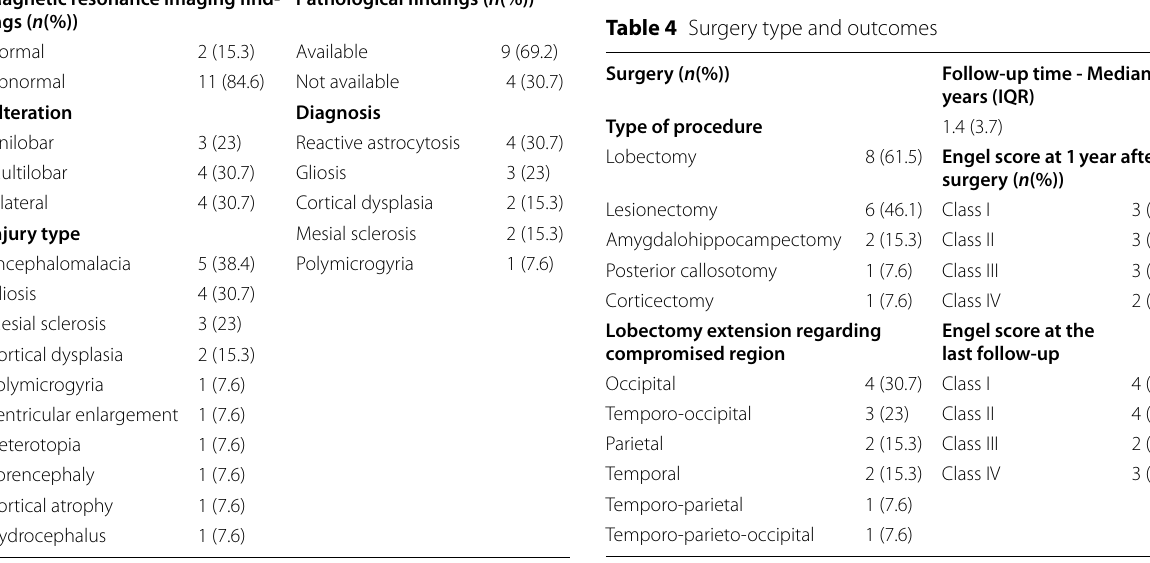
Table 3 Imagenological and pathological findings Magnetic resonance imaging find- ings ( n (%))